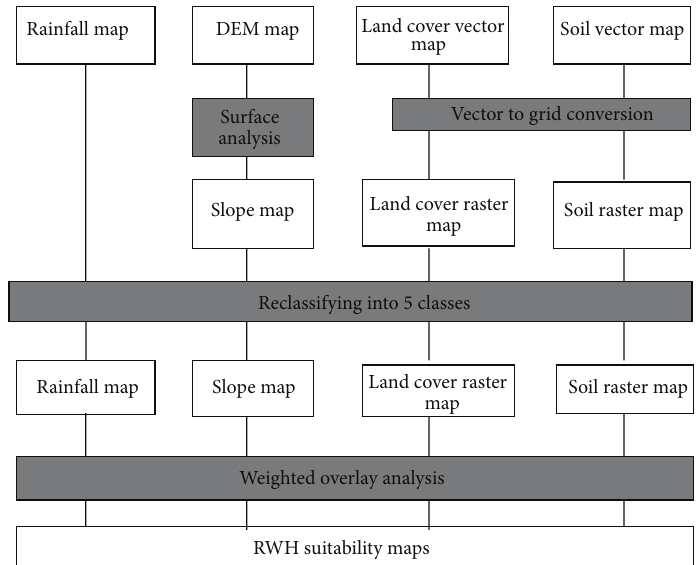
Figure 2: Flow chart of the data preparation and weighted overlay analysis for identifying the suitability of water harvesting systems.